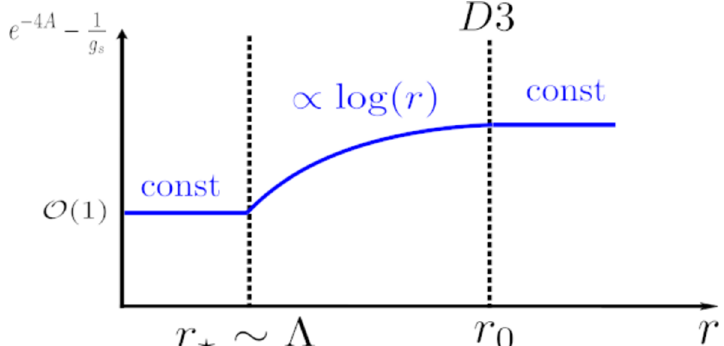
Figure 8 . Upon smearing the 2 N defects forming the N perturbative D7 branes along the angular circle we obtain a simplified effective model, where the conformal factor runs at one-loop in the exterior region r ∗ ≤ r ≤ r 0 and remains constant in the interior region r ≤ r ∗ . Also, we assume that the negative D3 charge on the D7 branes is screened by positive D3 brane charge at r = r 0 resulting in a constant profile at r ≥ r 0 which corresponds to the volume modulus.